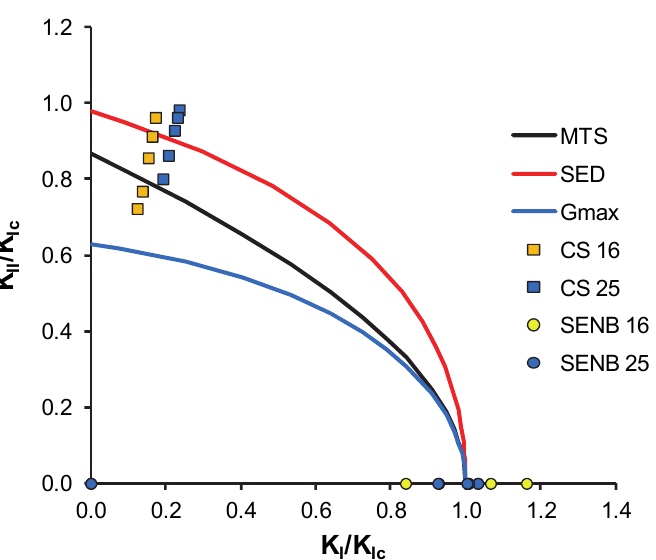
Figure 5: Comparison between fracture criteria and experimental